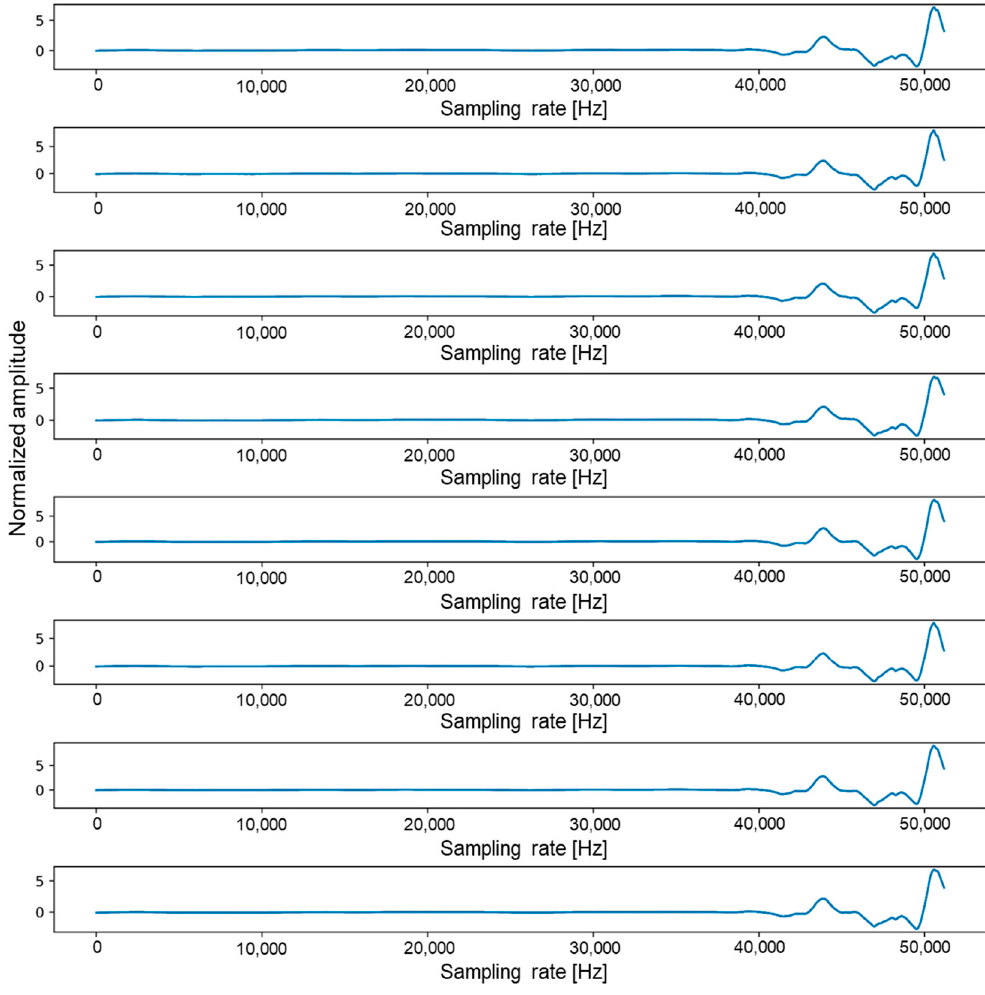
Figure 3. Graph of one dataset with sample size of 51,200 and 8 channels.